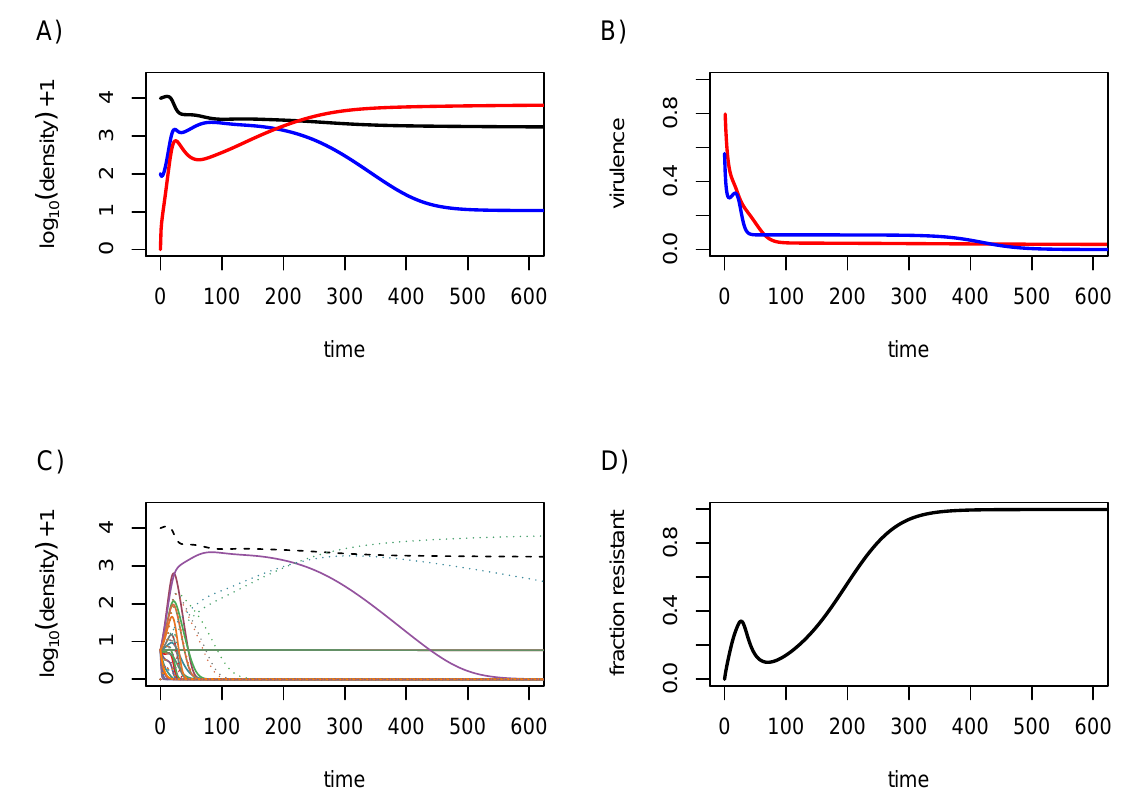
Figure 3 – Long term evolutionary dynamics. A) Dynamics of the densities of susceptible hosts (black), drug-susceptible infections (blue) and drug-resistant infections (red). B) Average virulence in the drug-sensitive (blue) and drug-resistant infections (red) for numerical multi-strain simulations. C) Dynamics of the densities of susceptible hosts (dashed black line), of drug-susceptible infections (plain coloured lines) and drug-resistant infections (dotted coloured line). Each colour corresponds to one of the n = 20 strains. D) Fraction of drug-resistant infections. Parameter values are the same as in Figure 2 for the multi-strain